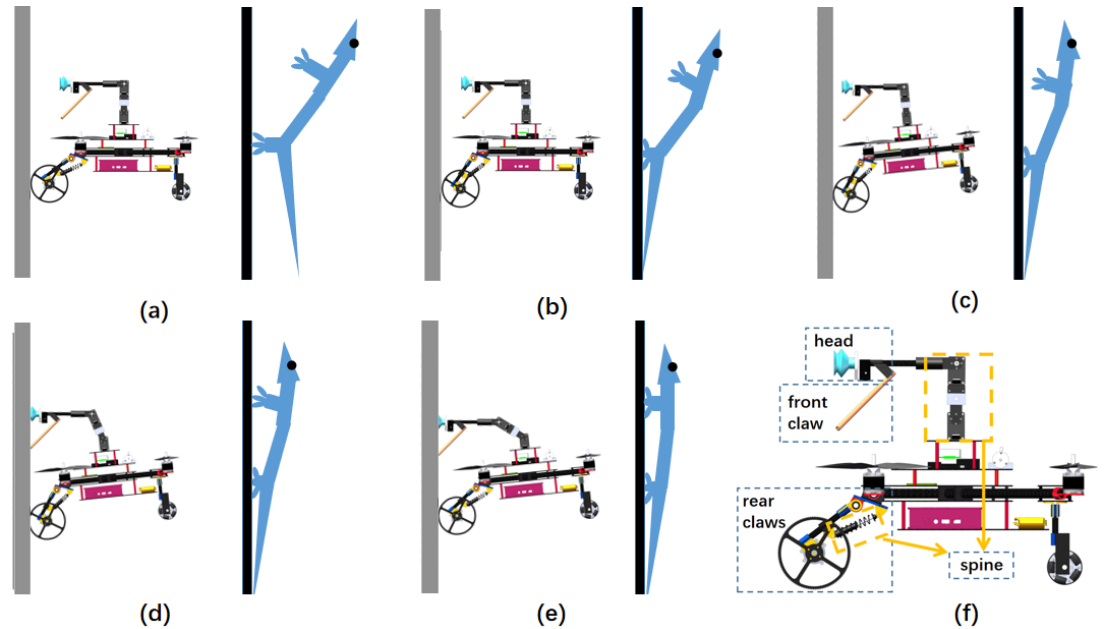
Figure 4. Adsorption process of the robot (LAWCDR) compared with the gecko (rotor lift keeps the wheels fixed on the wall). ( a ) The wheels start to contact the wall. ( b ) The wheels are compressed. ( c ) The robot uses the lift force generated by the propeller to attach the wheels to the wall. ( d ) The suction cup and support bars are driven towards the wall. ( e ) The suction cup makes the robot adsorb to the wall. ( f ) The correspondence between geckos and robots.